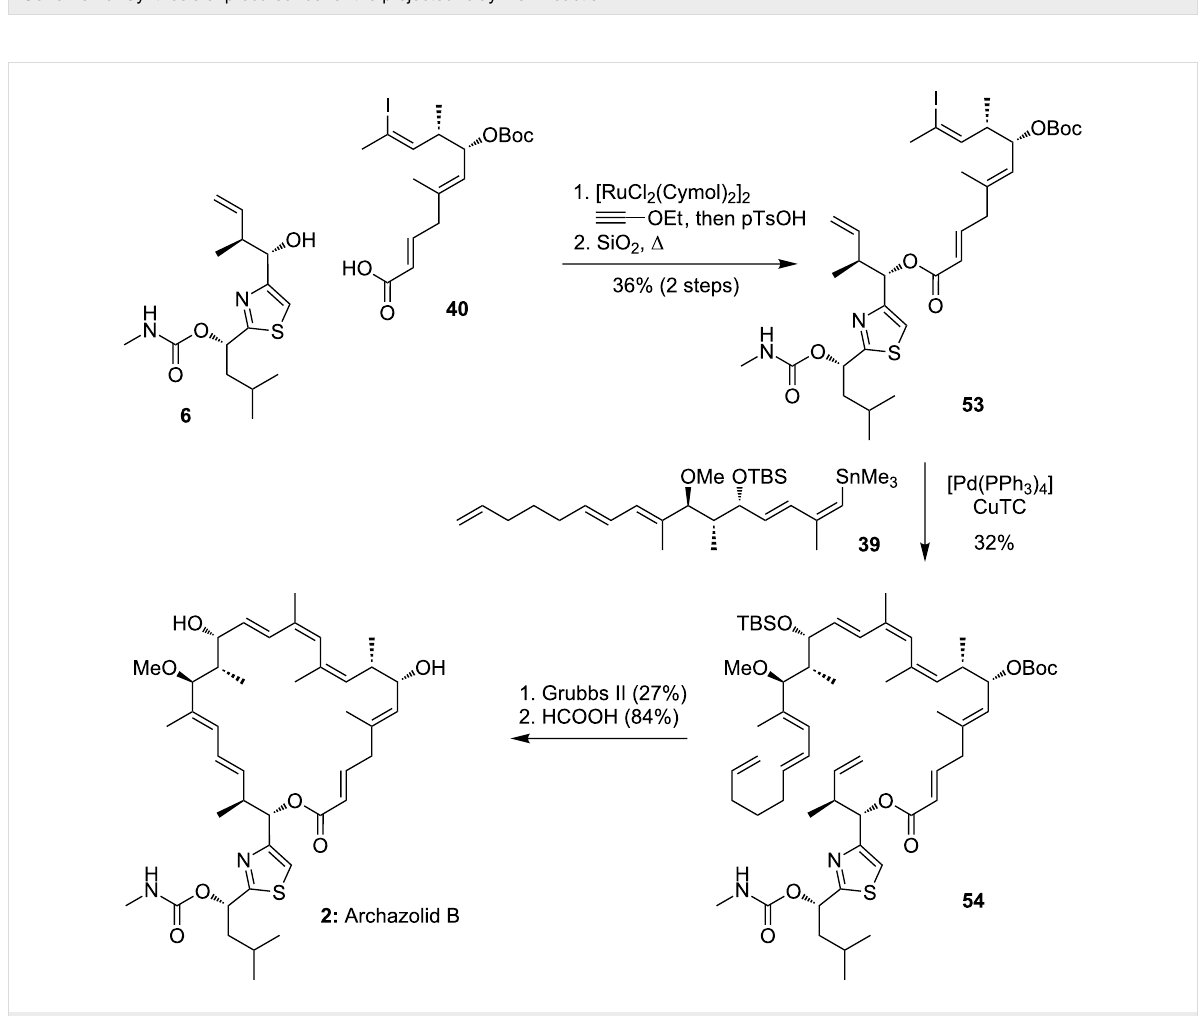
Scheme 11: Final steps of Trauner’s total synthesis of archazolid